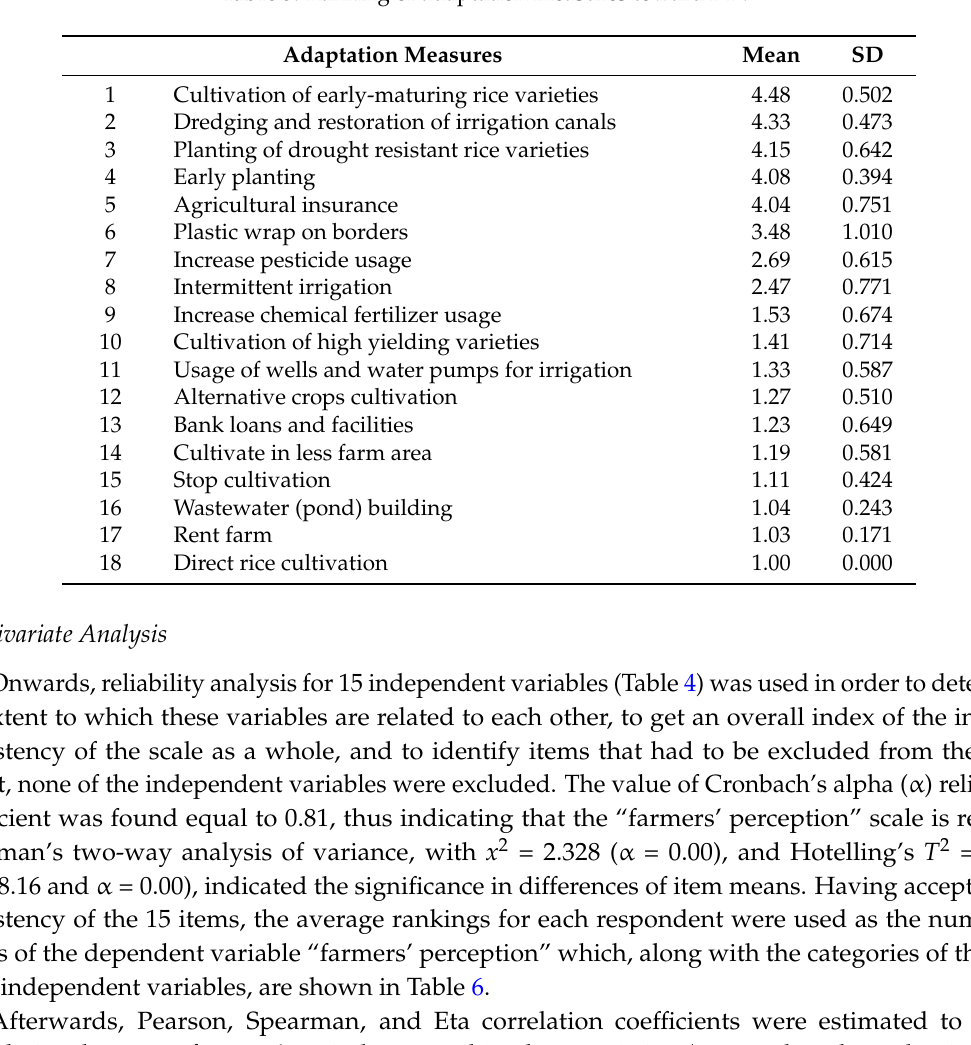
Table 5. Ranking of adaptation measures toward